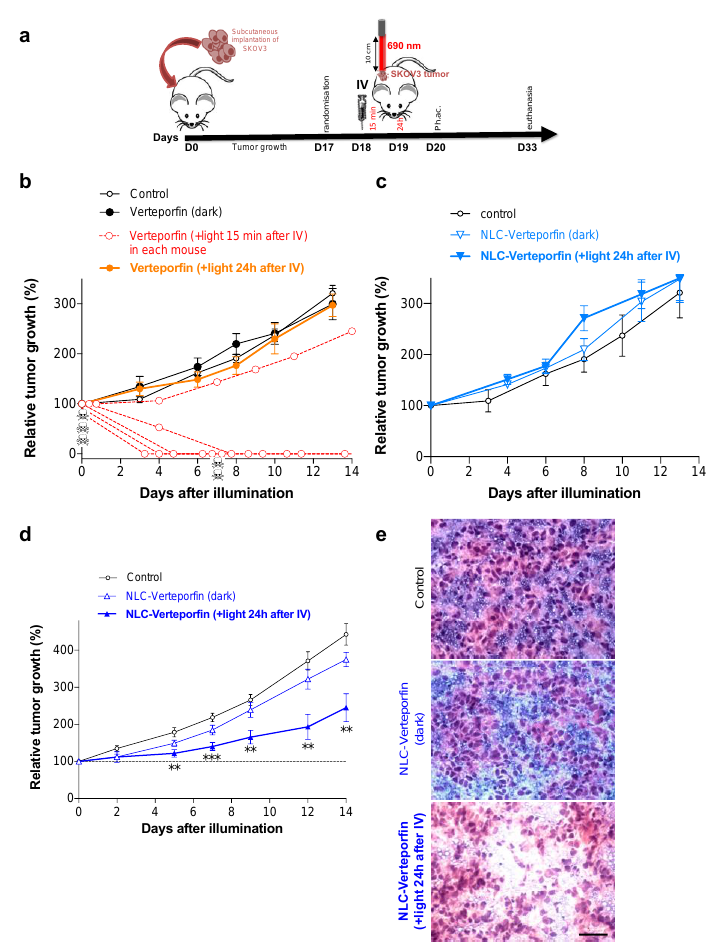
Figure 5. NLC-verteporfin improved PDT after intravenous administration in mice with ovarian cancer. ( a ) Mice with well-established SKOV3 subcutaneous tumors (125 ± 7 mm 3 ) were distributed into groups of 8 mice and treated by a single intravenous injection of free verteporfin, NLC-verteporfin or vehicle (control). Mice were maintained in the dark or submitted to a single NIR laser exposure 15 min or 24 h after injection. Non-invasive monitoring of tissue oxygenation (StO 2 ) was performed by in vivo photoacoustic imaging (Ph.ac.) on the tumors 24 h after light exposure. The tumor volume was evaluated by caliper measurements 3 times a week for 2 weeks. ( b – c ) Mice were injected with 1× PBS (control), free verteporfin (2 mg.kg − 1 ), or NLC-verteporfin (2 mg.kg − 1 of verteporfin), and tumors were exposed to 50 J.cm − 2 light 15 min or 24 h after the injection, as indicated. Data are expressed as the relative tumor growth (% of tumor volume on the day of light exposure) ± SEM in each group ( n = 8, except in the group treated with free verteporfin and exposed to light 15 min after IV injection of verteporfin, in which 5 mice died during the experiment, as illustrated by skulls). Dotted red lines represent the tumor volume of each mouse from the group exposed to 50 J.cm − 2 light, 15 min after free verteporfin injection. ( d ) Mice were intravenously injected with 1× PBS (control), or NLC-verteporfin (verteporfin 8 mg.kg − 1 ), and exposed to 200 J.cm − 2 light, 24 h after the injection as indicated. Data are expressed as the relative tumor growth (% of tumor volume at the day of light exposure) ± SEM in each group ( n = 8). p = 0.0003 ANOVA with Tukey post-hoc tests (**, ***, significantly different from the control group). ( e ) Hematoxylin and eosin staining on frozen tumor sections, Scale bar: 50 µm. Representative images in each group are shown.